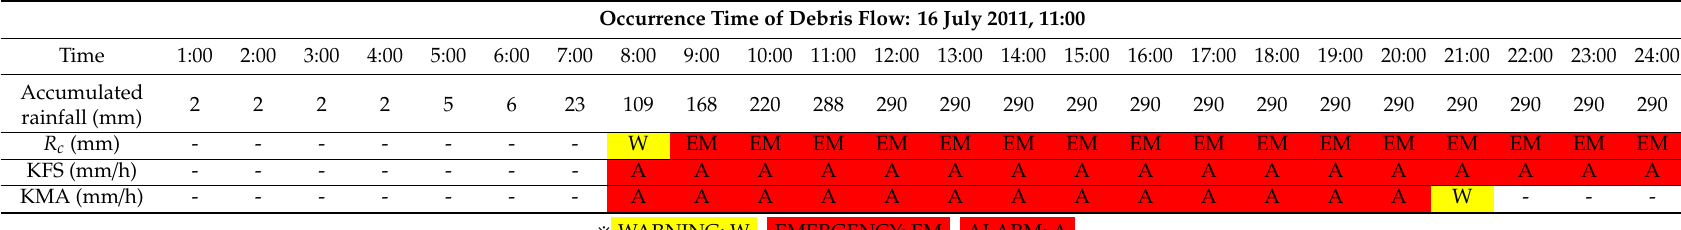
Table 8. Comparison of debris flow forecasting level results (Case